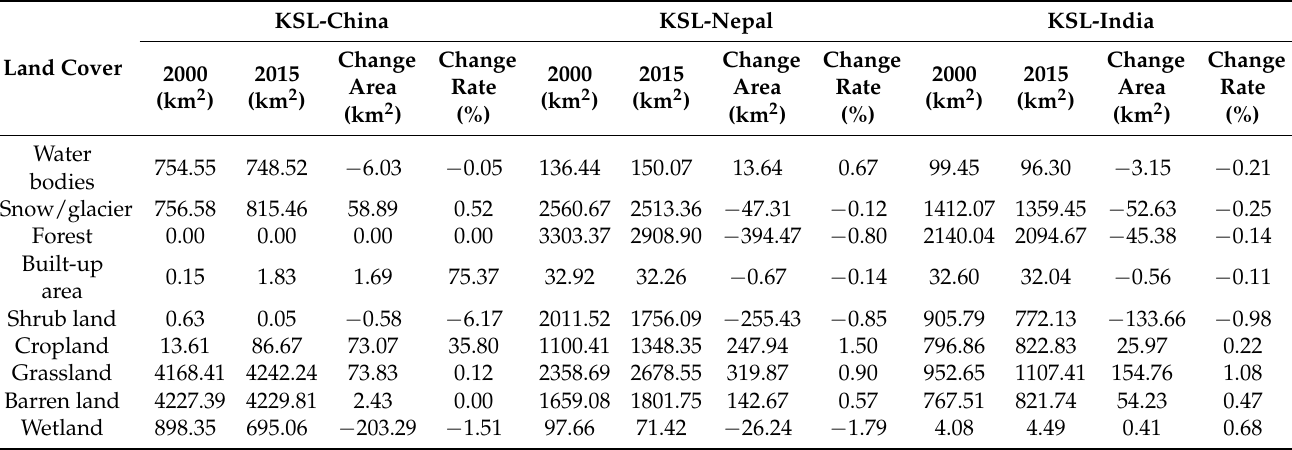
Table 6. Dynamic changes in LULC types between 2000–2015.